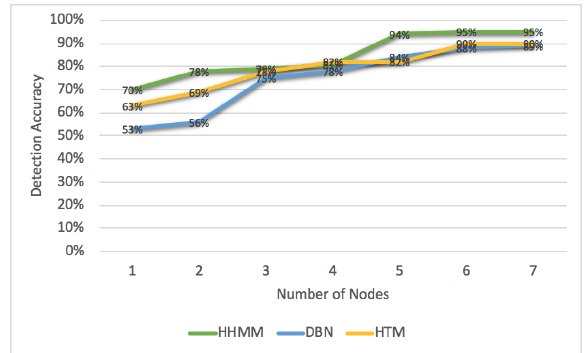
Figure 8. Comparative training time of HHMM, DBN and HTM.